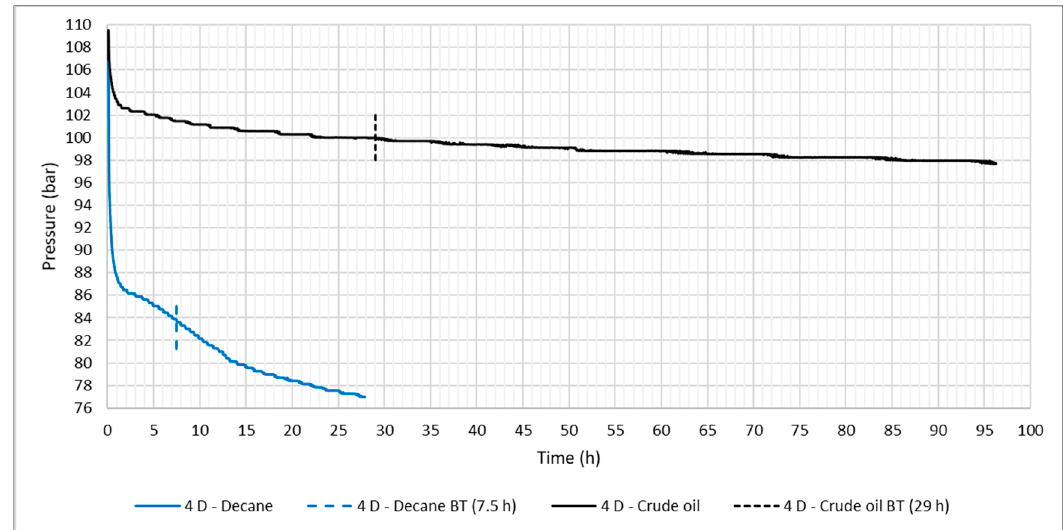
Figure 9. CO 2 pressure decay comparison for 4 D porous media tests with n -decane (test 3) and crude oil (test 5) including breakthrough (BT) times.